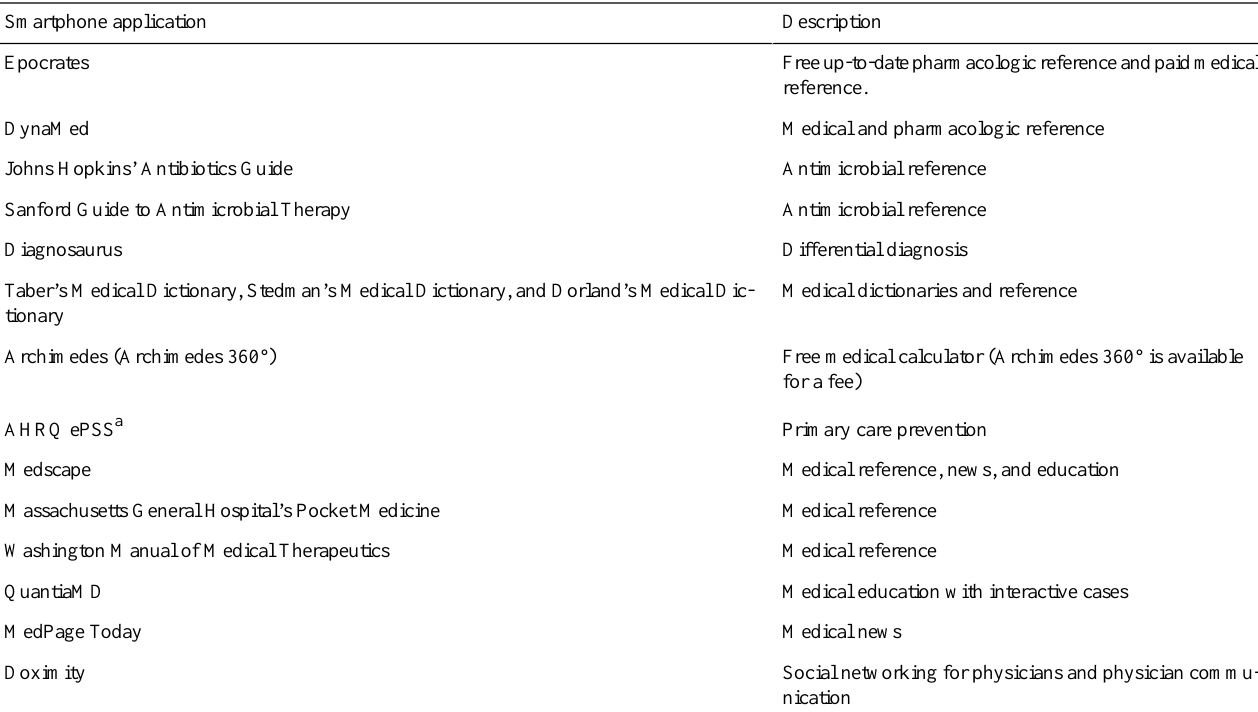
Table 1. List and description of popular medical applications for